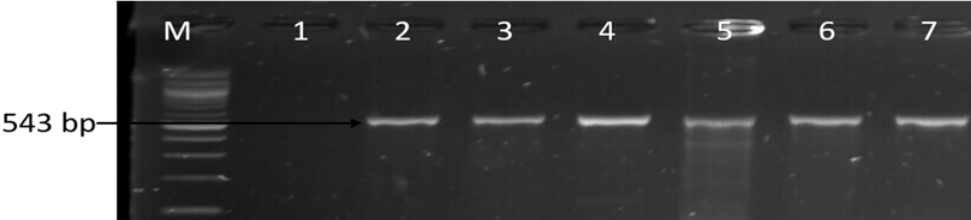
Figure 9. A representative electrophoresis picture of various amplified antibiotics resistance genes of Campylobacter isolates. Lanes M: DNA ladder (100 bp), lane 1: negative control, lane 2: ampC gene (530 bp), lane 3: tetA (201 bp) and tetB gene (359 bp), lane 4: ermB gene (320 bp), lane 5: gyrA gene (441 bp), lane 6: aac(3) ‐ IIa (aacC2) a gene (740 bp) and lane 7: tetM gene (159 bp).